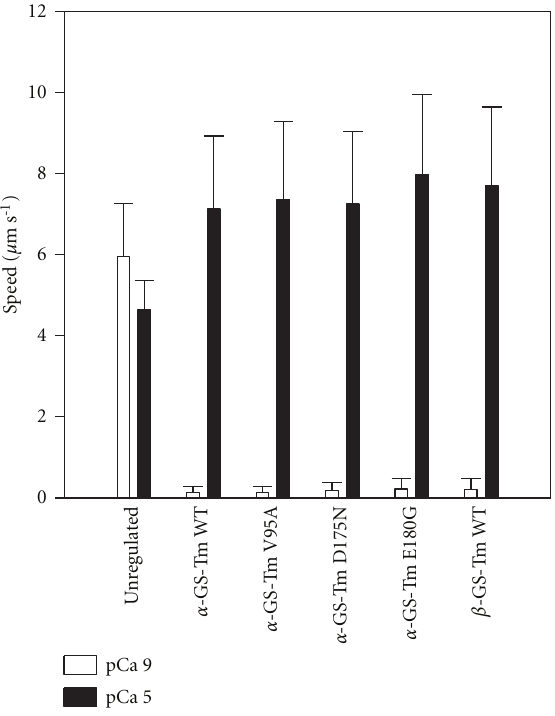
Figure 2: In vitro motility speeds at pCa 5 (solid bars) or pCa 9 (open bars) for regulated thin filaments ( α -GS-Tm WT, α -GS- Tm V95A, α -GS-Tm D175N, α -GS-Tm E180G, or β -GS-Tm WT and HcTn), or at pCa 5 (solid bars) or in actin bu ff er (AB)-based motility bu ff er (pCa ∼ 9; see Section 2.5) for unregulated F-actin. Values are the weighted mean + S.D. for 4–10 flow cells (weighted by the number of filament paths tracked in each flow